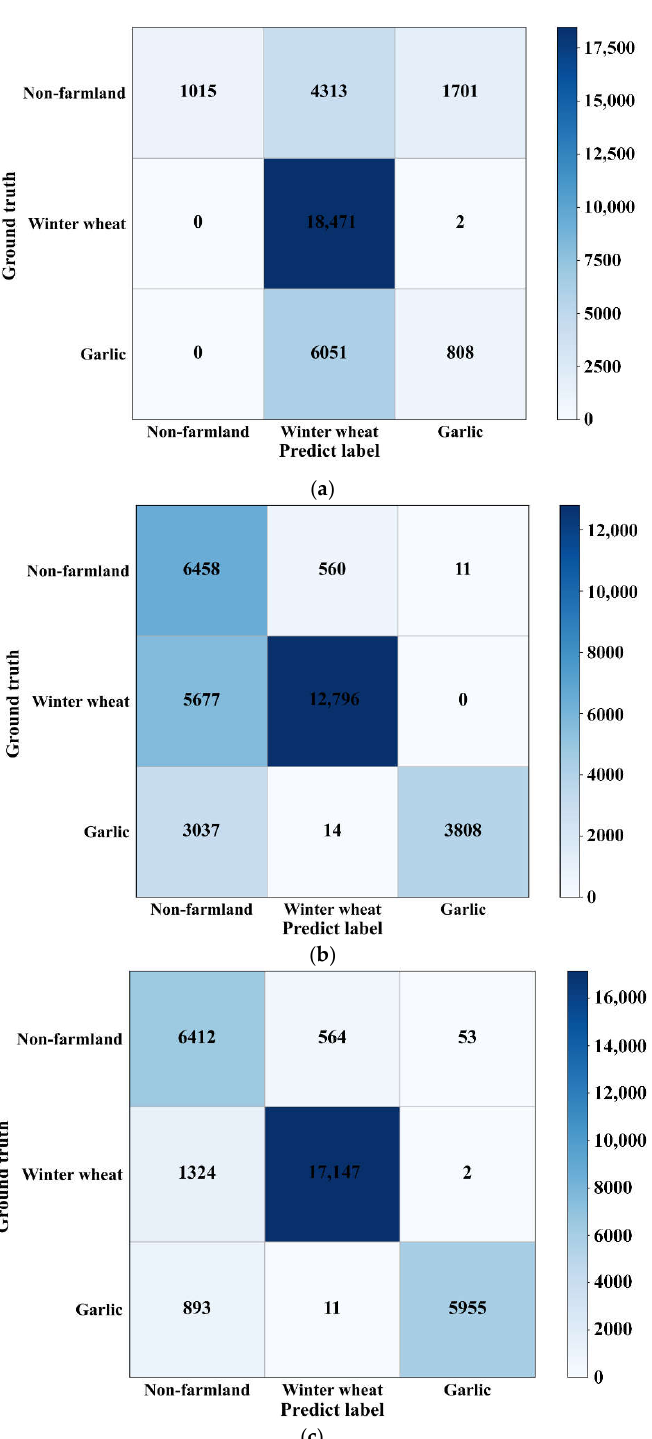
Figure 8. Confusion matrices for models generated by different classifiers. ( a ) 1D-CNN; ( b ) GDSSM; ( c )